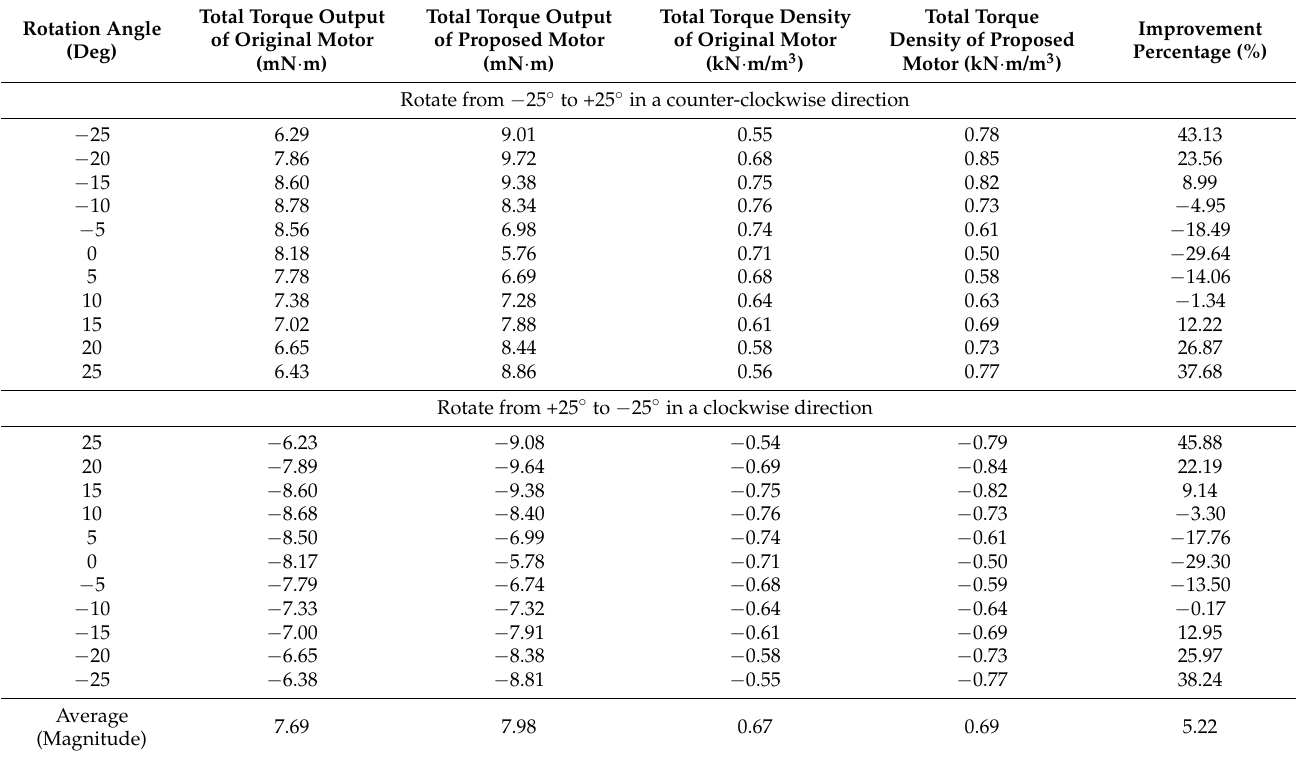
Table 5. Comparison of the torque output and torque density of original and proposed 3-DOF spherical motor. Total Torque Output Rotation Angle of Original (Deg)